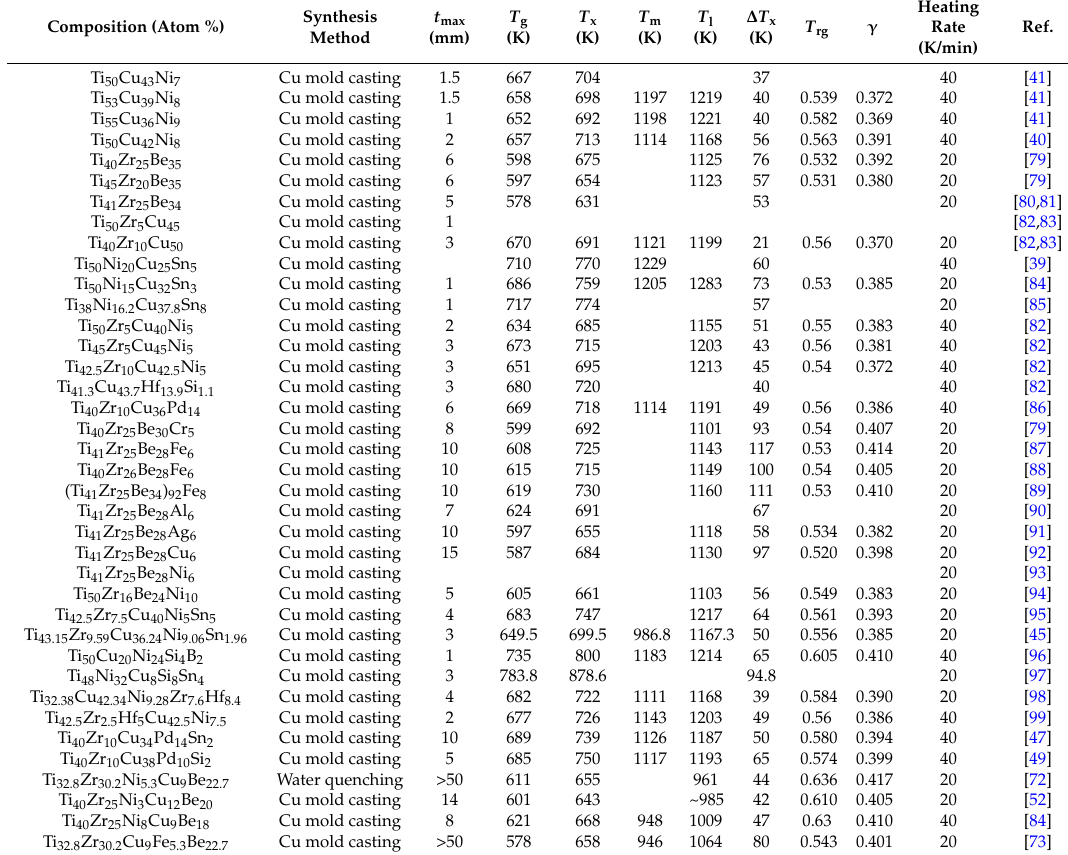
Table 1. Thermal properties of typical Ti-based BMGs